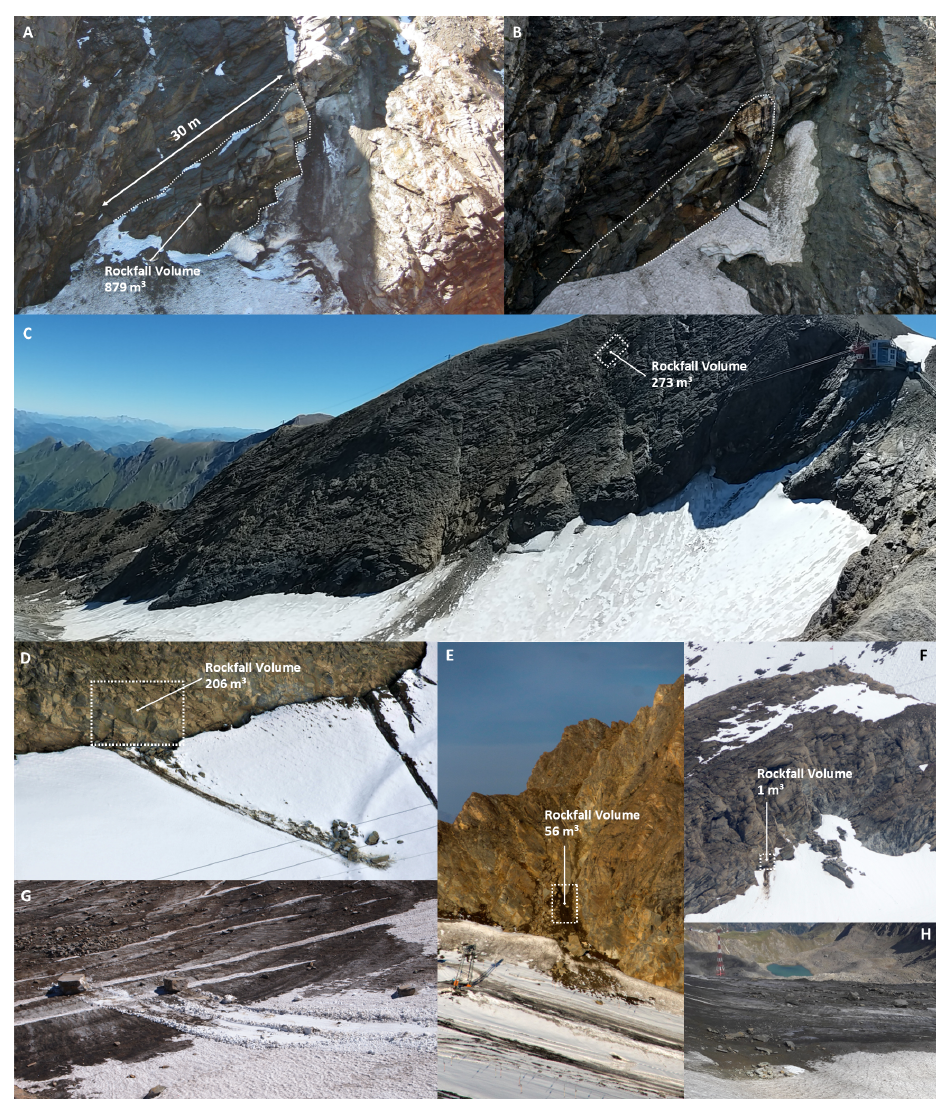
Figure 8. Documentation of rockfall events for all monitored rockwalls. (a) Pre-event topography of the largest rockfall registered in the study period at KN (879.4 ± 6.3m 3 ); the dotted line marks the (still-attached) blocks which were released during the event. The remnant of an ice apron is visible directly right of the source area (photo: Markus Keuschnig, 17 August 2011); (b) post-event topography; source area is marked by dotted line. Note the difference in colour between the fresh source area (bright surface) and the terrain above (dark surface) (photo: Robert Delleske, 28 August 2019); (c) fresh deposits on the glacier surface after 272.7 ± 11.4m 3 (second largest event recorded) of rock detached 97m above the glacier at KNW (photo: Ingo Hartmeyer, 26 August 2016); (d) 206.3 ± 11.6m 3 rockfall at the foot of MKE (photo: Ingo Hartmeyer, 05.11.2011); (e) fresh rockfall deposits below a couloir at the south end of MGE after a 56.2 ± 4.1m 3 rockfall (photo: Robert Delleske, 12 September 2012); (f) small rockfall event (1.3 ± 0.3m 3 ) at MKW (photo: Robert Delleske, 12 September 2012); (g) cubic blocks deposited on the glacier after event described in panel (a) (photo: Ingo Hartmeyer, 17 August 2012); (h) extensive cover of old rockfall deposits on the central part of the Schmiedingerkees (photo: Ingo Hartmeyer, 18 September